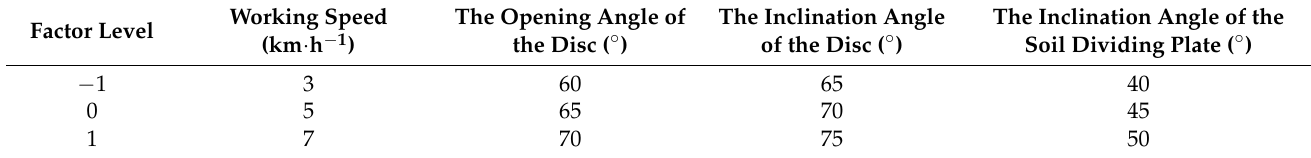
Table 2. Factors and Levels of Quadratic Orthogonal Rotational Regression Combination Test of Operation Effect of Soil-Covering Device.